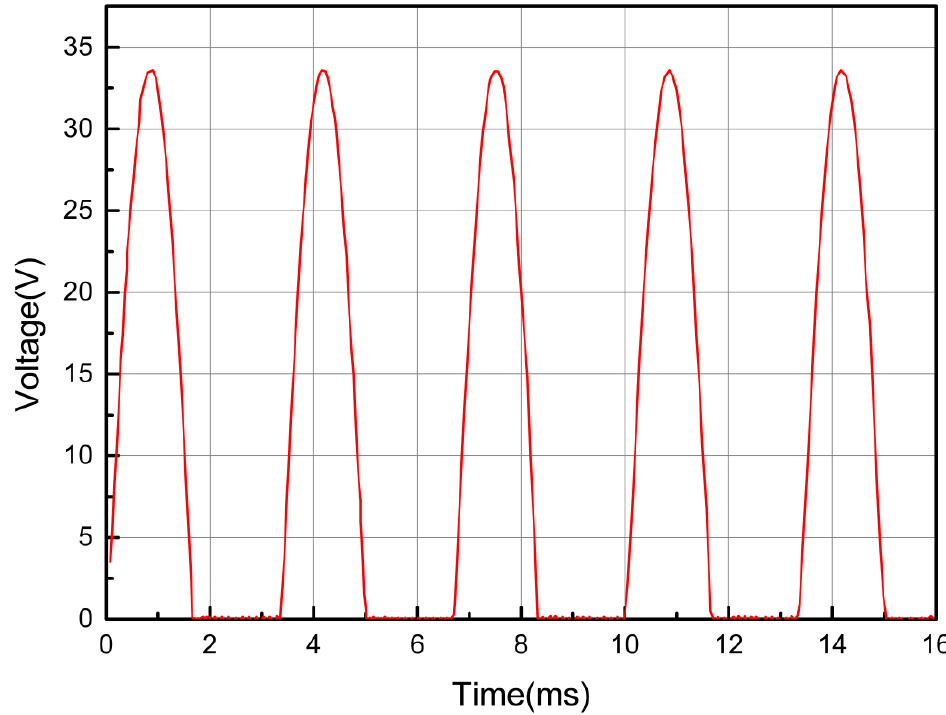
Figure 10. Output voltage waveform at 3000 r/min and 300 W.